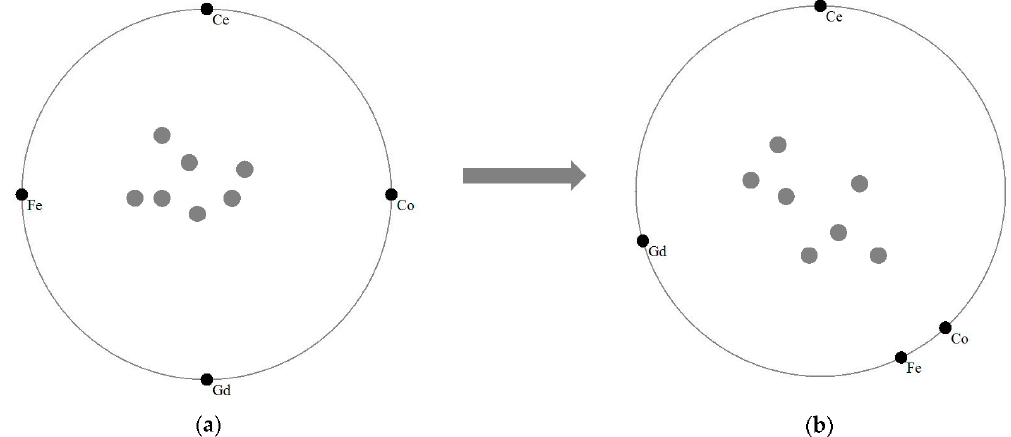
Figure 5. Attribute layout schemes: ( a ) original RadViz layout; and ( b ) distance-spaced RadViz layout. Table 2. RadViz vs. RadViz Deluxe in terms of the various layout errors.